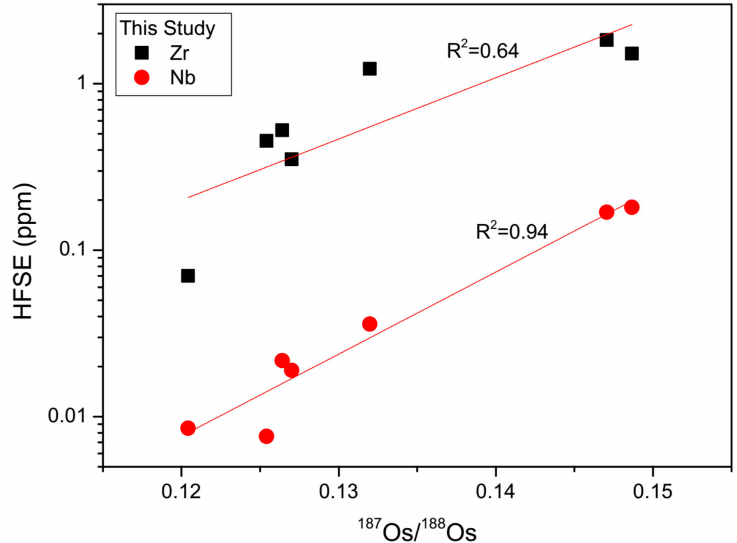
Figure 8. Plot of 187 Os / 188 Os versus high field-strength elements (HFSE) (Zr and Nb) content of the Yap Trench peridotites. Correlation lines are drawn by linear